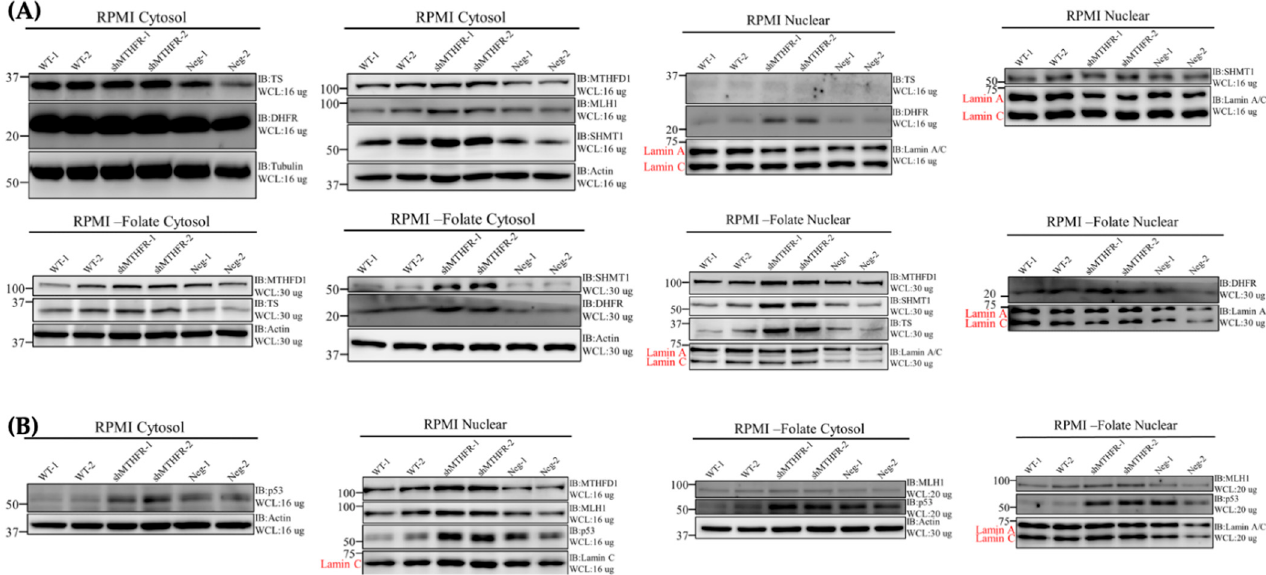
Figure 3. shMTHFR enhanced cytosolic and nuclear SHMT/DHFR/TYMS protein complex, MTHFD1 ( A ), as well as DNA repair protein MLH1, and p53 expressions ( B ) in folate repletion and folate depletion. The quantifications of SHMT/DHFR/TYMS and MTHFD1 are shown in Table 4. The total abundance of the SHMT/DHFR/TYMS protein complex (combined cytosol and nucleus) significantly increased by shMTHFR, especially under folate depletion. Folate depletion induced MTHFD1 expression in shMTHFR and such induction was more drastic in the nucleus in response to folate depletion (Table 4B). These results may account in part for the stable isotopic tracer experiments using L- [3- 13 C]-serine. After cells were initially depleted of folate and then supplemented with low dose folinate, deoxythymidine monophosphate (dTMP) enrichments (dT+1 represents M+1 of dTMP) from [3- 13 C]-serine were significantly higher in shMTHFR compared to Neg and WT (Table 5). In addition, shMTHFR induced hMLH1 and p53 expression in both folate depletion and repletion, consisting with the finding of reduced DNA instability (Table 6A,B) in shMTHFR. The quantifications of MLH1 and p53 protein expression are shown in Table 6C. Moreover, folate restriction decreased nuclear and cytosol hMLH1 and p53 protein abundance, and shMTHFR recovered the reduction of hMLH1 and p53, especially in the nucleus (Figure 3B, Table 6C). Abbreviations: SHMT1, serine hydroxymethyl-transferase1; TS, thymidylate synthase; DHFR, dihydrofolate reductase; MTHFD1, methylenetetrahydrofolate dehydrogenase; hMLH1, human Mut L homologue - 1.